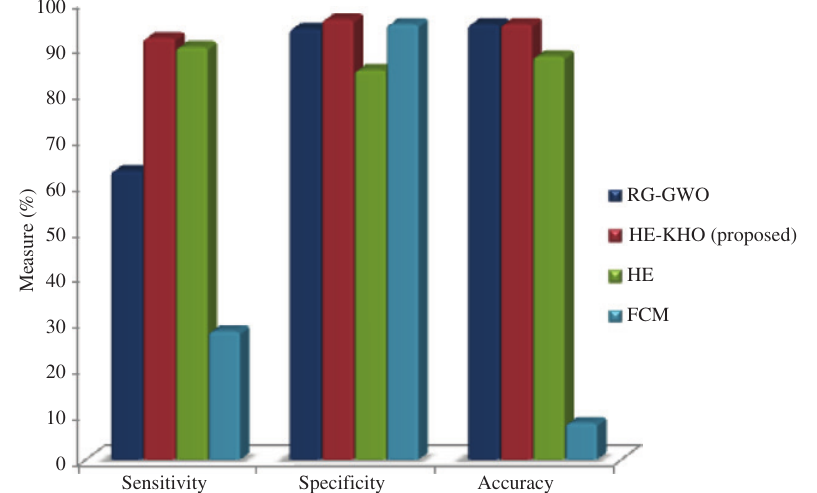
Figure 5: Comparative Analysis.